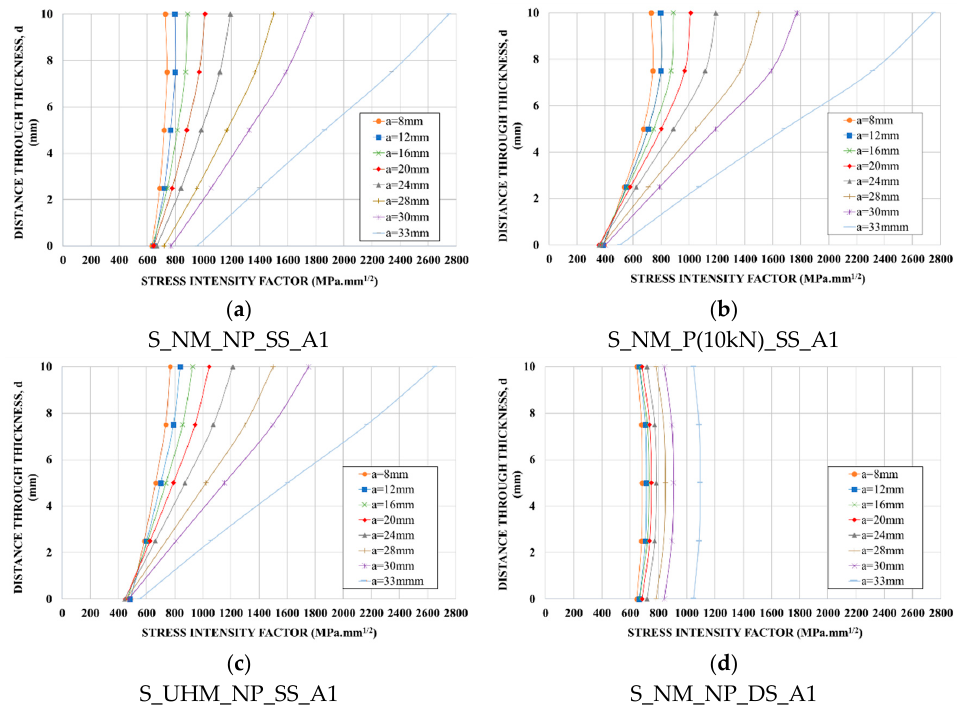
Figure 9. Distribution of SIF along crack front for strengthened specimens obtained from FEM results: ( a ) normal modulus (NM)-non-prestressed single-sided repair specimen; ( b ) NM-pre-stressed single-sided repair specimen; ( c ) ultra-high modulus (UHM)-non-prestressed single-sided repair specimen; ( d ) NM-non-prestressed double-sided repair specimen.